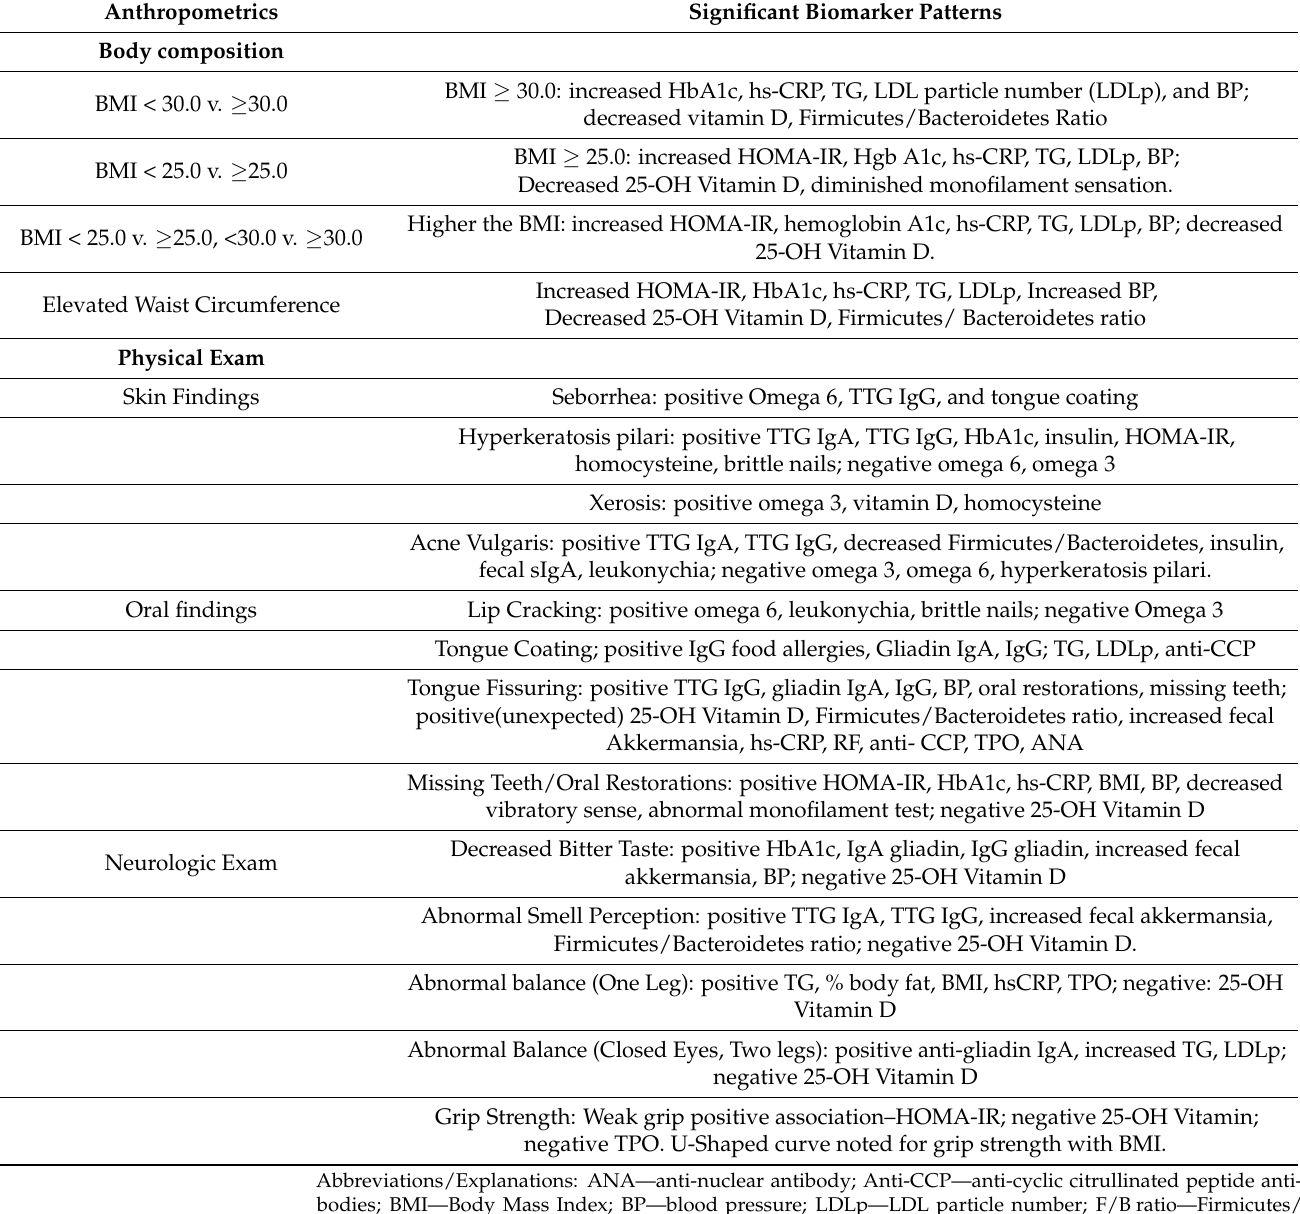
Table 5. Statistically Significant Associations ( p ≤ 0.05) between Physical Exam/Anthropometric Findings and BioMarkers.